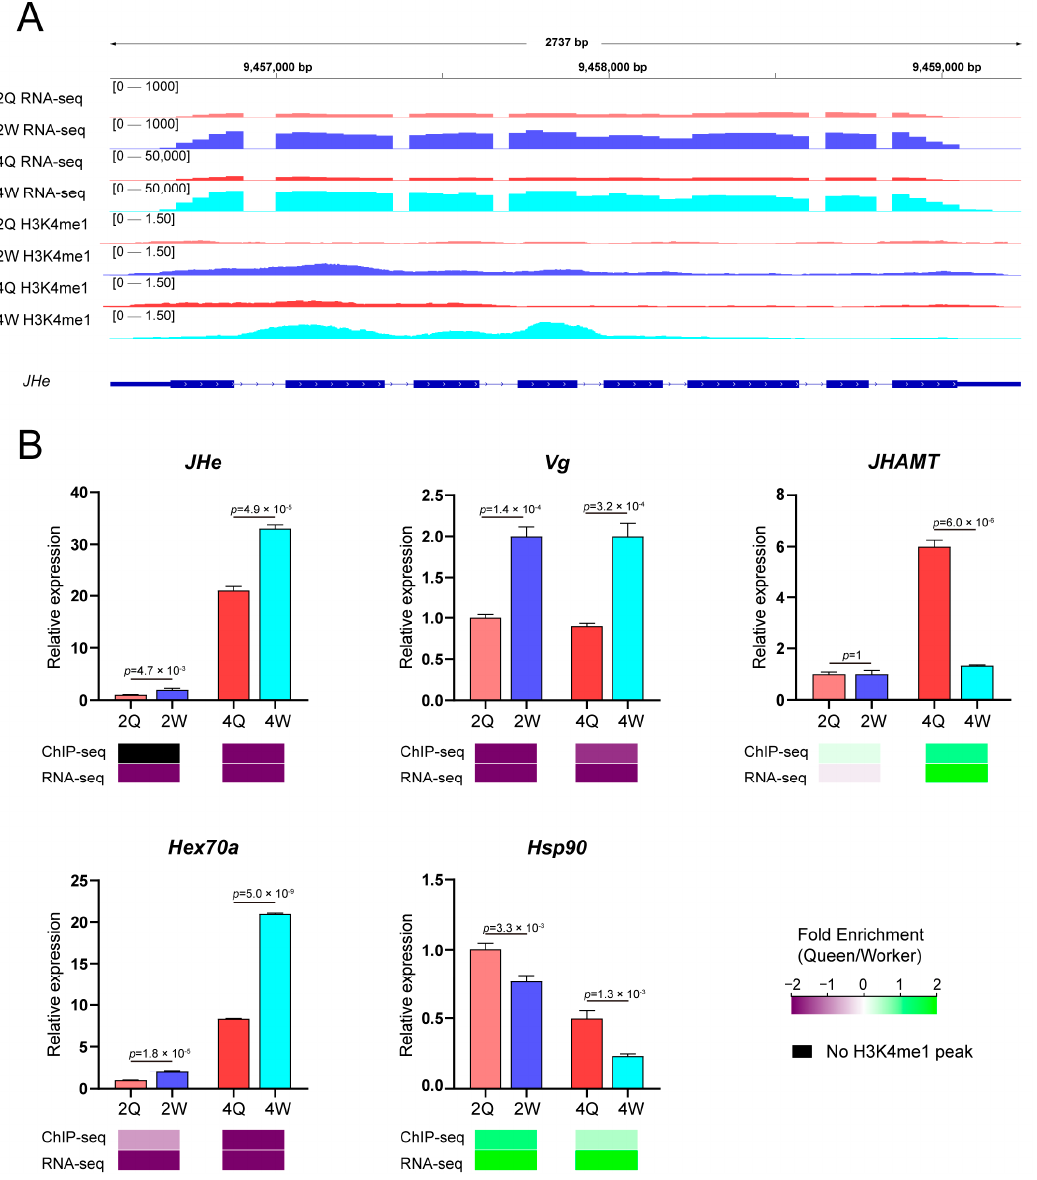
Figure 4. Function of H3K4me1 modification in caste differentiation by modulating the expression levels and modification abundance of genes. ( A ) Juvenile hormone esterase ( JHe ; LOC406066). The gene in this region reached genome-wide significance ( p ≤ 0.01) at both the 2nd and 4th instars, and had a greater than two-fold difference in H3K4me1 modification. ( B ) RNA expression levels and H3K4me1 abundance of differentially expressed candidate caste-differentiation-related transcripts are shown. Expression levels are expressed as mean ± SEM relative to a reference gene ( GAPDH ; LOC726445) in three replications. Fold enrichment is the difference in abundance between queen larvae and worker larvae; green denotes a higher fold enrichment, while purple denotes a lower fold enrichment. Differences in relative expression levels were analyzed using t -tests.